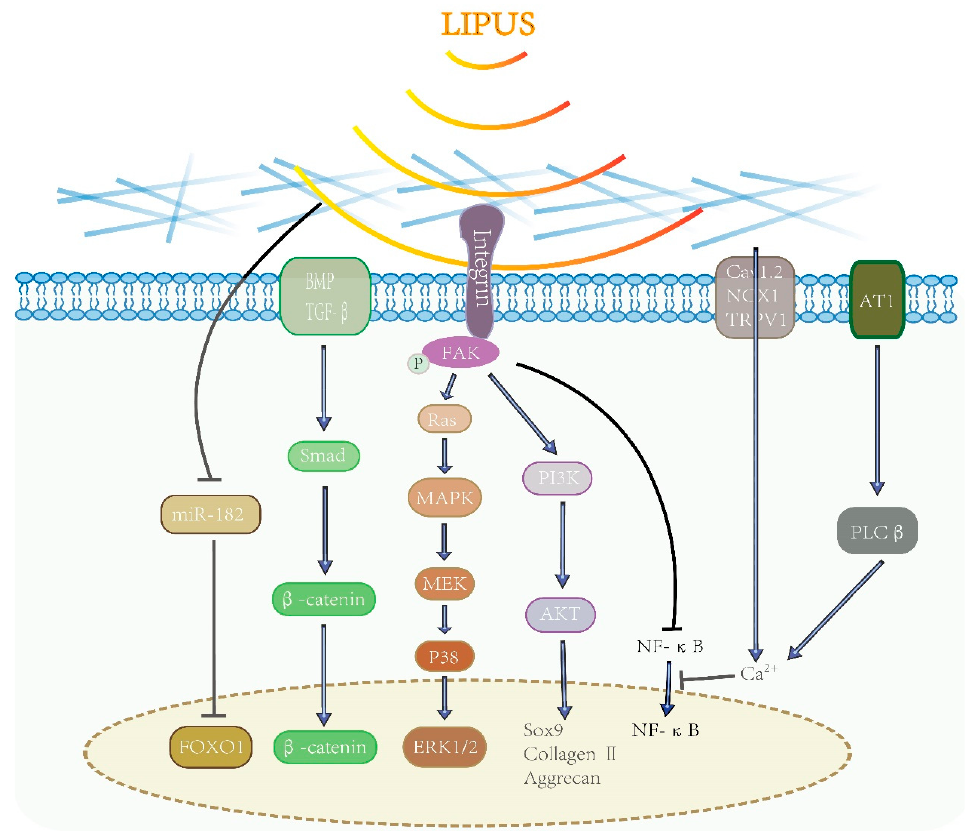
Figure 1. LIPUS alleviates oral diseases by modulating multiple signaling pathways. LIPUS can regulate diverse signaling pathways. Integrin and FAK mainly participate in the signal transduction of LIPUS. Through the integrin/FAK complex, the p38 MASK pathway and the PI3K-AKT pathway can be activated to promote osteogenic differentiation. LIPUS also inhibits NF- κ B directly. Besides, LIPUS contributes to the AT1-PLC β -Ca 2+ pathway and calcium influx. And the increased Ca 2+ further suppresses the nuclear translocation of NF- κ B which promotes the reduction of inflammatory response. LIPUS also accelerates FOXO1 transcription by inhibiting miR-182 and then activates osteogenesis-related factors. Interestingly, Smad has a double effect. On one hand, Smad, which is assembled by LIPUS-activated BMP, plays a role in osteogenesis. On the other hand, LIPUS can stimulate the TGF- β -Smad pathway to repair the dentin-pulp complex.